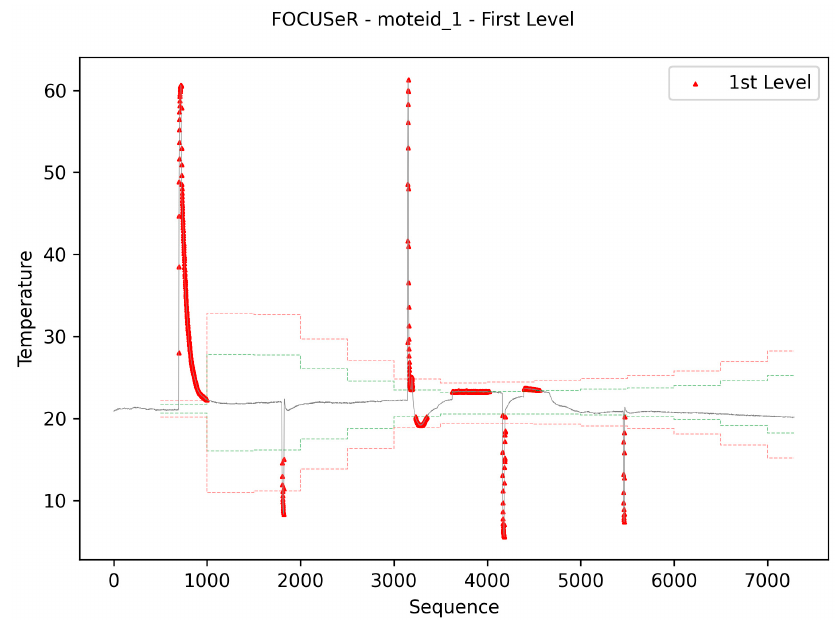
Figure 5. Division of data into normal, anomaly, and failure values using the IQR metric.